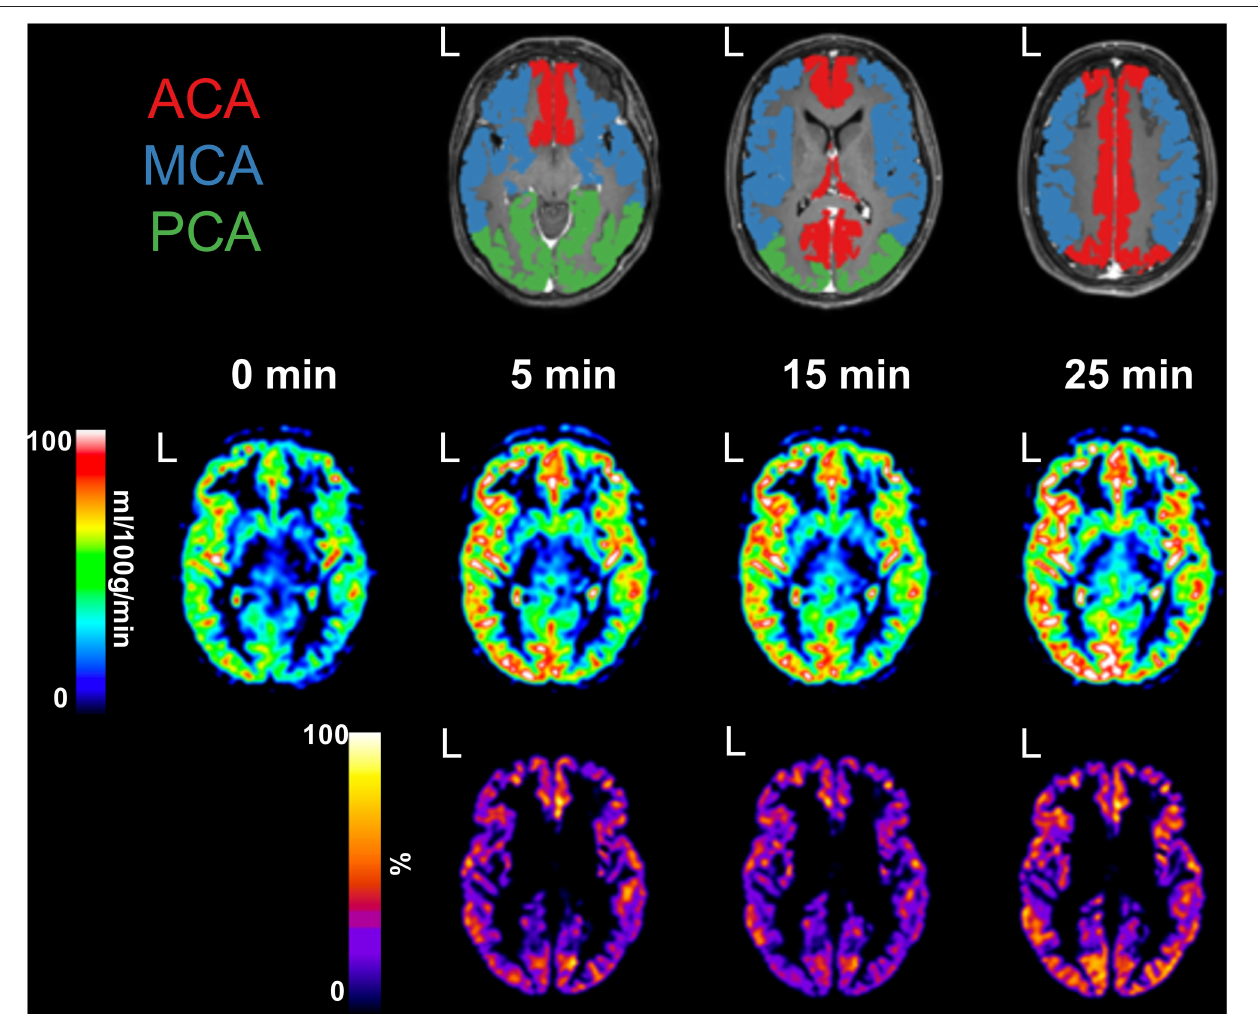
FIGURE 1 | Preoperative examination of a female patient, aged 26 years, with confirmed bilateral moyamoya disease [Suzuki grade III left internal carotid artery (ICA) and grade IV right ICA]. An anatomical contrast-enhanced T1-weighed image shows defined vascular territories, including bilateral anterior cerebral artery (ACA, red), middle cerebral artery (MCA, blue), and posterior cerebral artery (PCA, green). L, denotes left side. Cerebral blood flow maps were acquired at baseline and 5, 15, and 25min post-acetazolamide injection. Cerebrovascular reserve maps were calculated for each time point and presented masked with all vascular territories